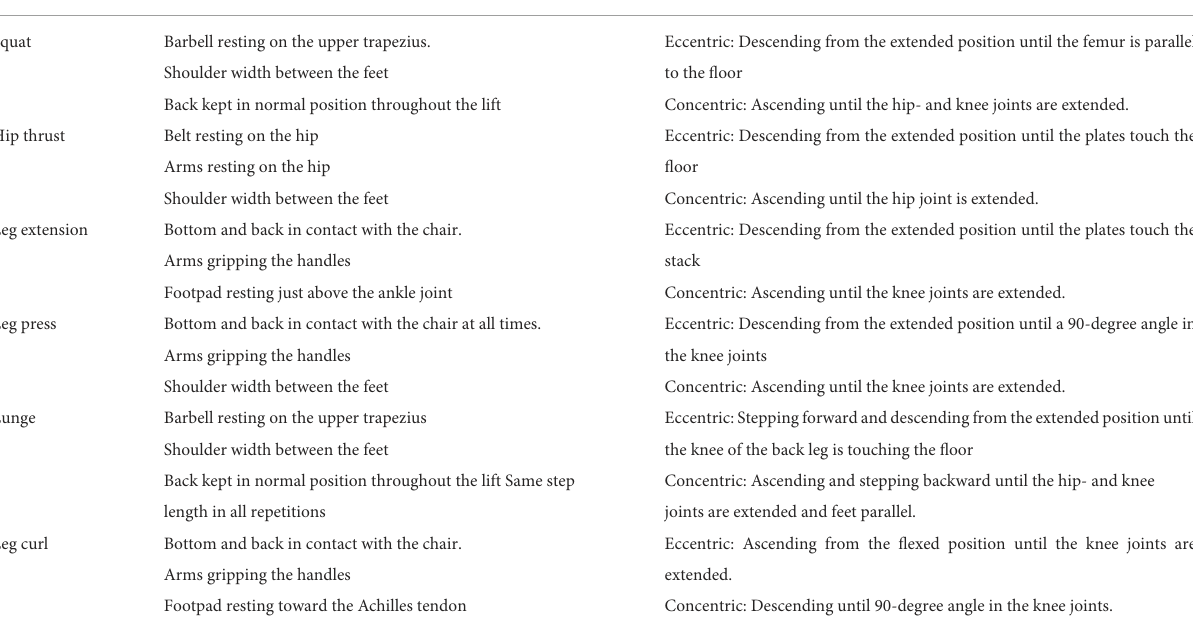
TABLE 1 Description of standardizations and execution of the different exercises. Exercise Execution of the reps/ range of